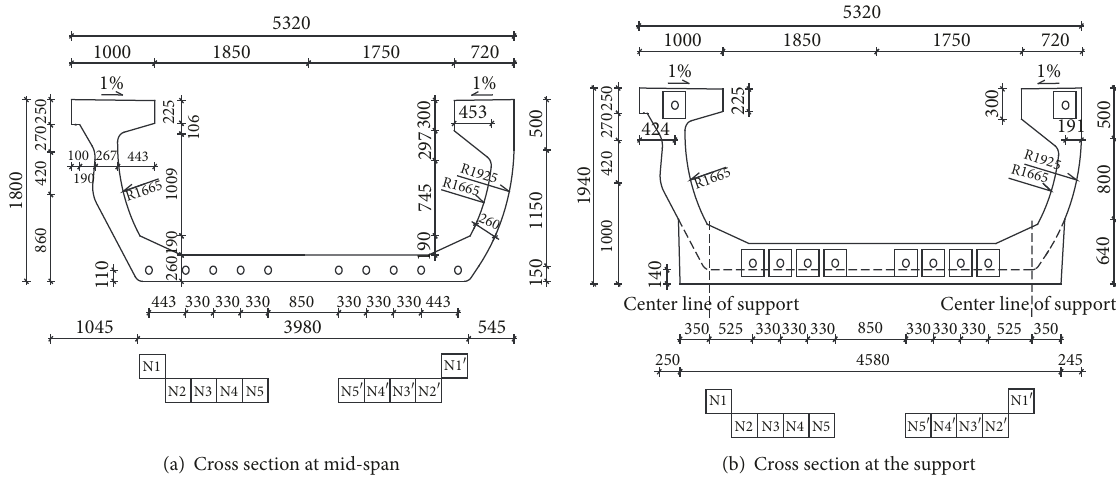
Figure 4: Cross section of U-shaped girder (unit: